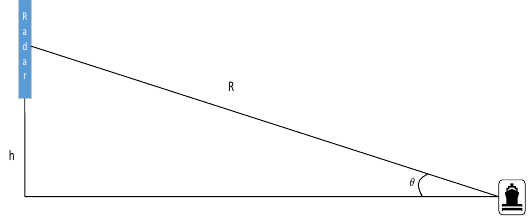
Figure 5. Experimental geometric observation model.